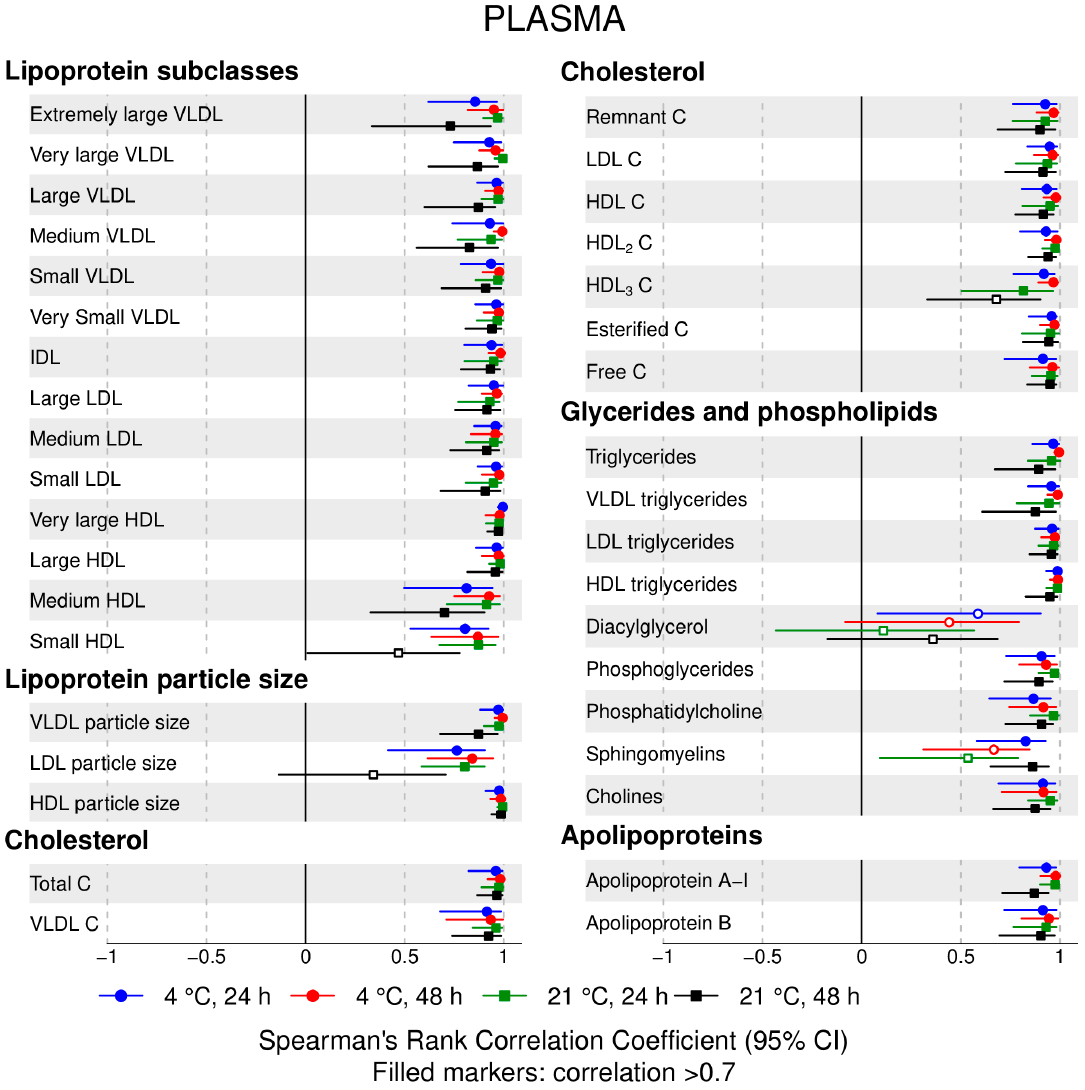
Figure 3. EDTA-plasma, pre-storage handling effects: Spearman’s rank correlation coefficients between metabolic trait concentration/value in reference samples (4 °C, 1.5 h) and samples incubated at (i) 4 °C, 24 h; (ii) 4 °C, 48 h; (iii) 21 °C, 24 h; and (iv) 21 °C, 48h, before centrifugation (correlations for lipoprotein trait details are given in Figure S2, Supplementary Materials). Spearman’s rank correlation coefficients and 95% confidence intervals (CIs) are listed in Table S3, Supplementary Materials. C, cholesterol; IDL, intermediate-density lipoprotein; LDL, low-density lipoprotein; HDL, high-density lipoprotein; VLDL, very low-density lipoprotein.